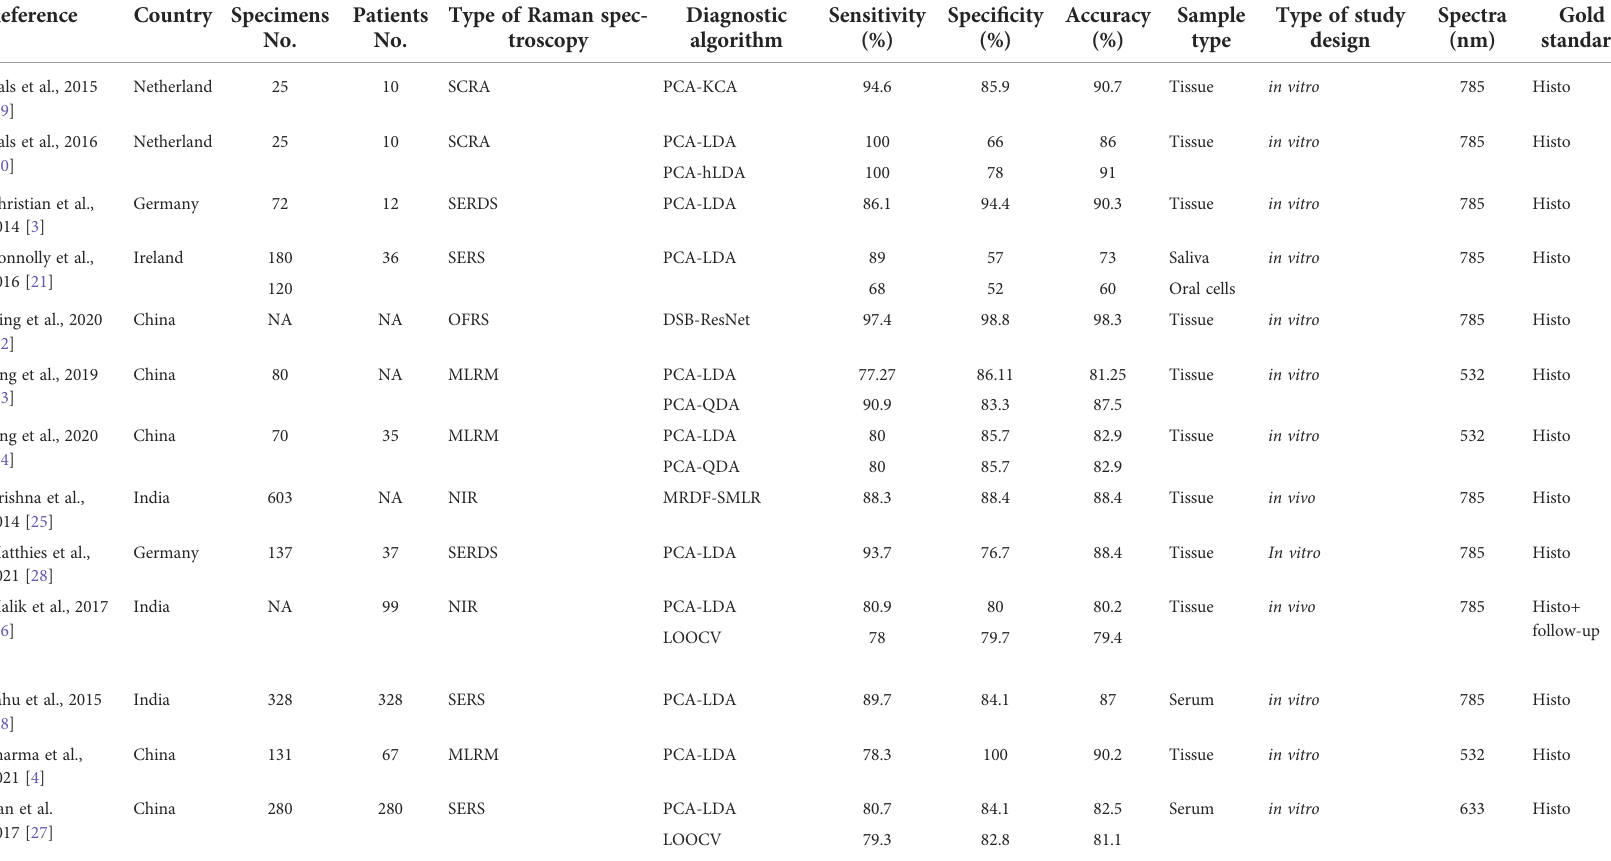
TABLE 1 Characteristics of the studies